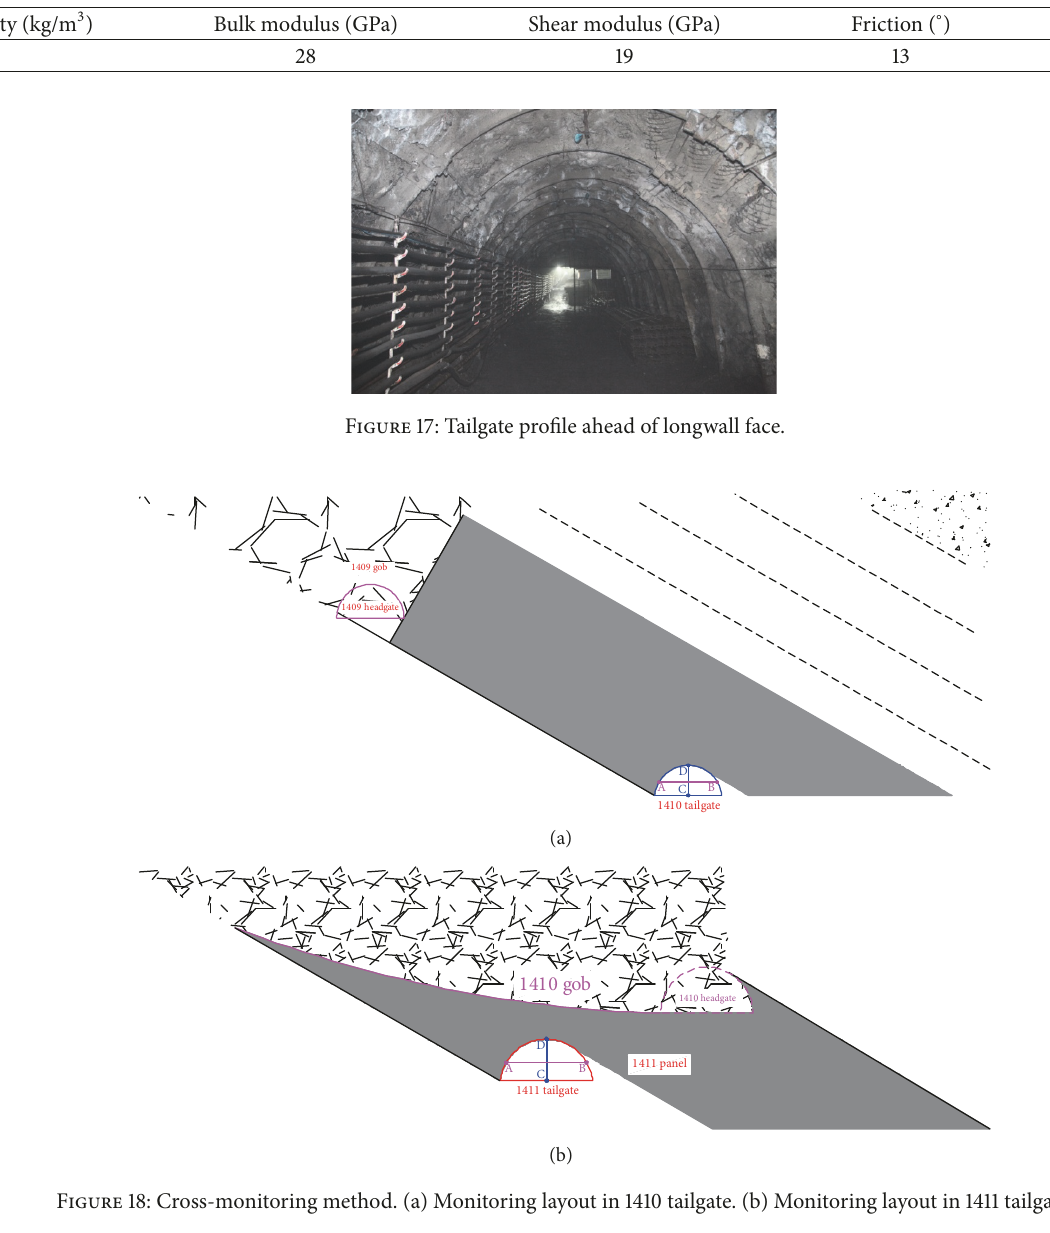
Table 6: Parameters for gob material.